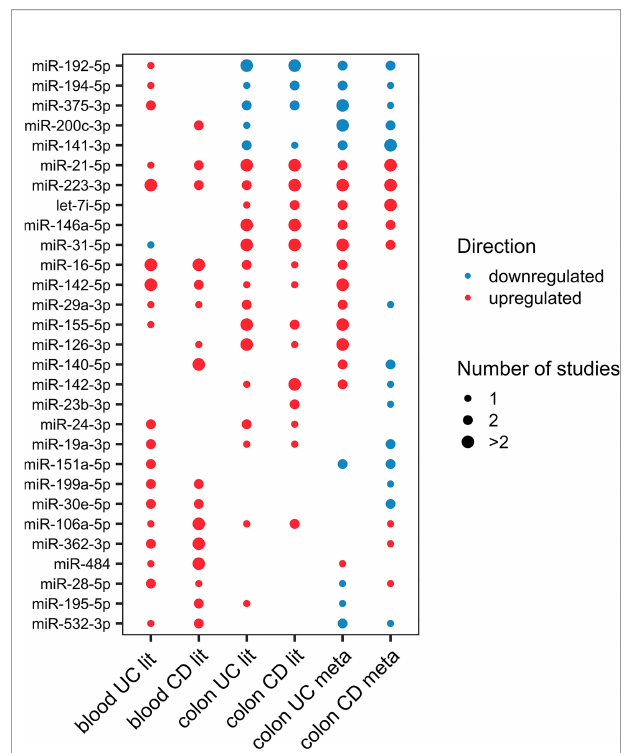
FIGURE 1 | Dot-plot of the 29 differentially expressed miRNAs (at least two studies) in either colon or blood of UC or CD from literature. The node size represents the number of studies, and the node color corresponds to the expression statues, where red means upregulation and blue means